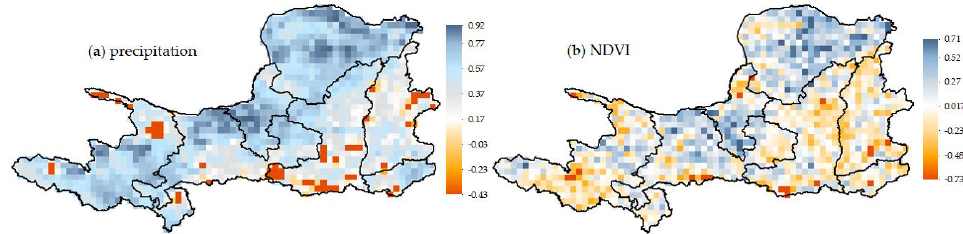
Figure 14. Correlation between precipitation, NDVI, and SM from 2000 to 2015: ( a ) Precipitation, ( b )